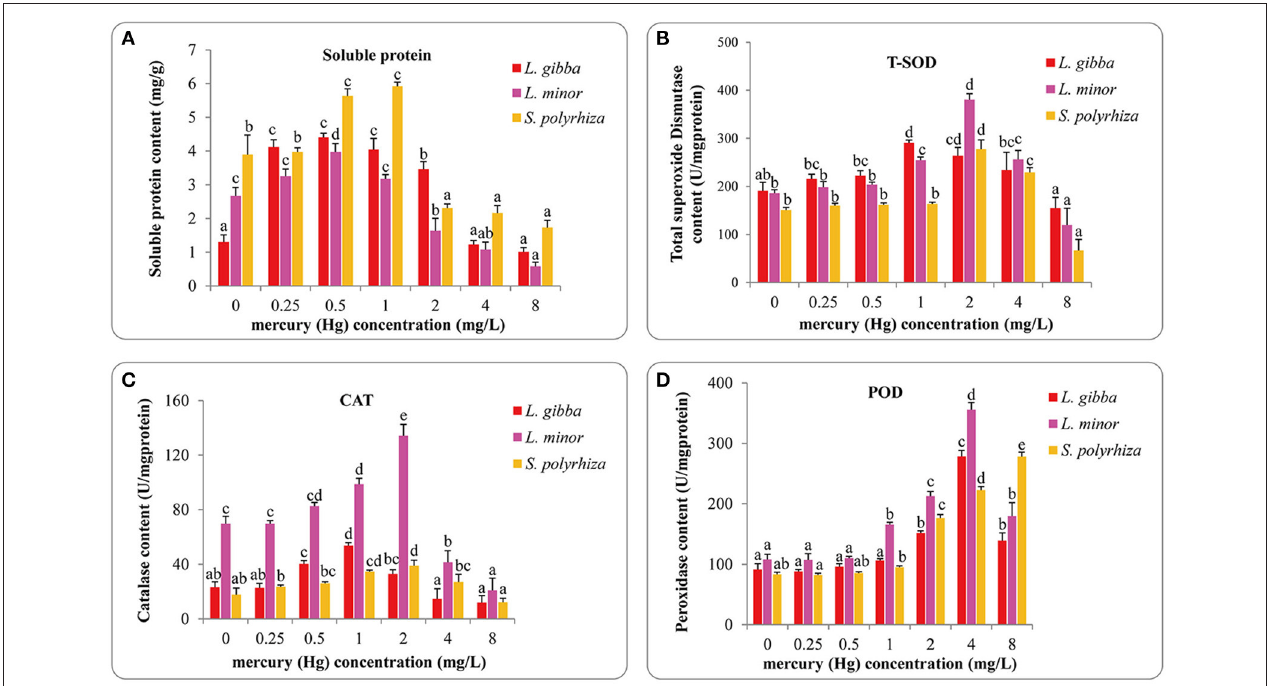
FIGURE 3 | Effects of different concentrations of Hg on the content of soluble protein (A) and activities of T-SOD (B) , CAT (C), and POD (D) of three duckweed lines. Indices were measured after 7 days treatment and calculated based on the fresh weight (FW). The letters (a, b, c, d, e) on the column graphs indicated Tukey tests analyses results among different Hg treatments in the same duckweed. The same letters indicated no significant differences and different letters indicated significant difference among treatments. Error bars indicated standard deviation.